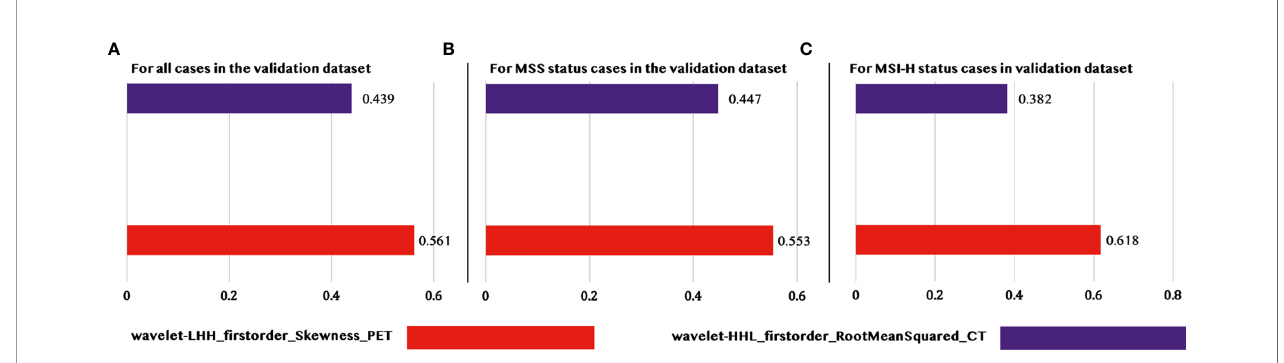
FIGURE 4 | Feature importance for predicting MSI status of patients with CRCs in different situations. (A) Feature importance for predicting all the patients in the validation set. (B) Feature importance only for predicting the patients with MSS in the validation set. (C) Feature importance only for predicting the patients with MSI- H in the